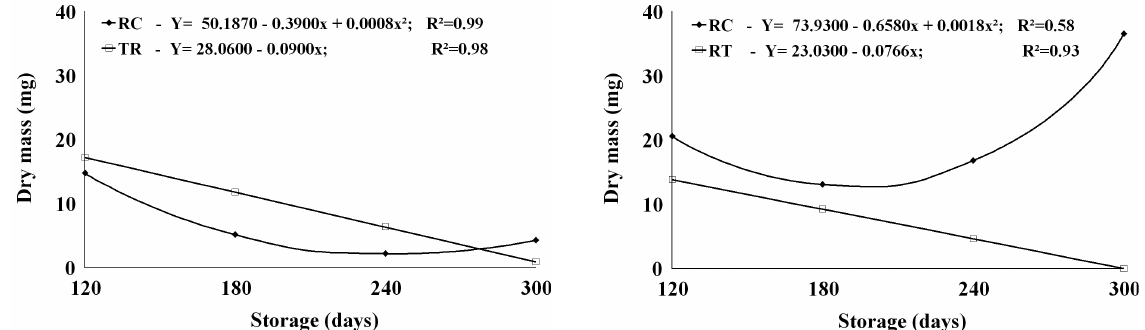
Fig. 8- Dry mass of Croton urucurana seedlings from the seeds stored at room temperature (RT) and under refrigeration condition (RC) and incubated at 20/30°C (a) and in under greenhouse conditions